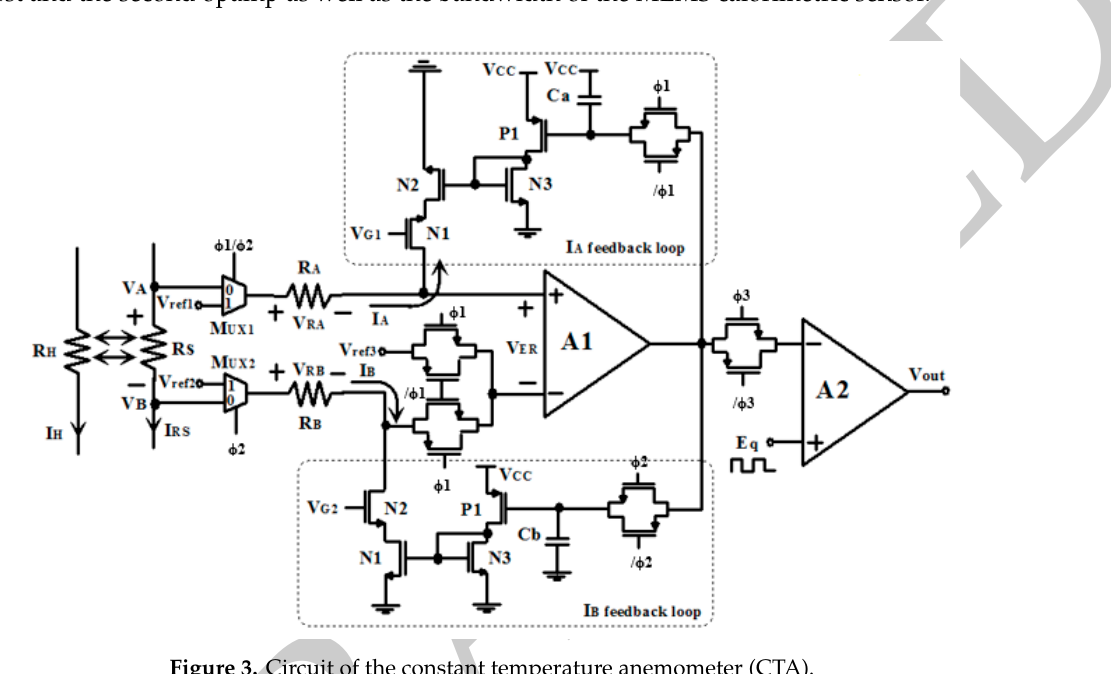
Figure 3. Circuit of the constant temperature anemometer (CTA).